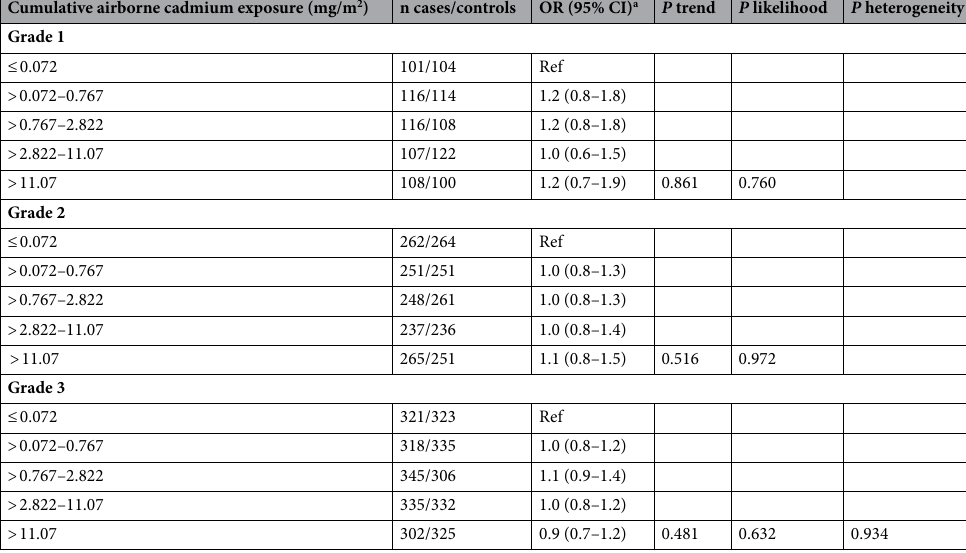
Table 3. Odds ratio and 95% confidence intervals (OR, 95% CI) for the association of quintiles of the cumulative airborne cadmium exposure with breast cancer risk by grade of differentiation in the case–control study nested within the E3N cohort, France, 1990–2008. a Multivariable models were adjusted for physical activity, tobacco smoking status, alcohol intake, level of education, body mass index, age at menarche, age at first full-term pregnancy, parity, breastfeeding, oral contraceptive use, menopausal hormone replacement therapy use, status of birthplace, previous family history of breast cancer and personal history of benign breast disease. P likelihood: P-values from likelihood ratio test comparing the statistically significance of the global effect of the quintiles. P heterogeneity: comparing heterogeneity of associations across breast cancer grade at